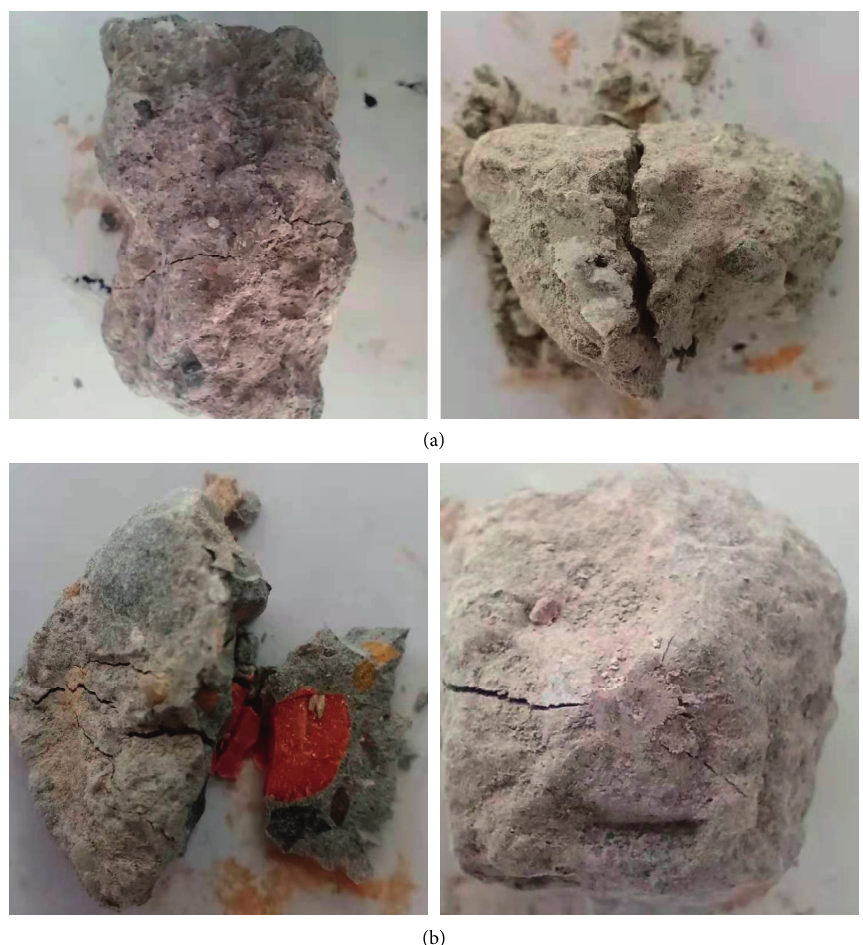
Figure 5: Crushing mode of recycled aggregate particles of concrete. (a) Single crack crushing. (b) Multicrack crushing.